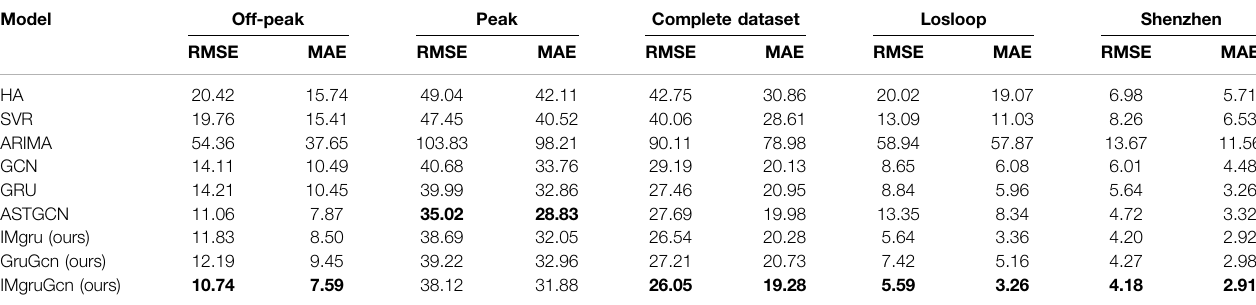
The bold values are represent the best prediction result of all